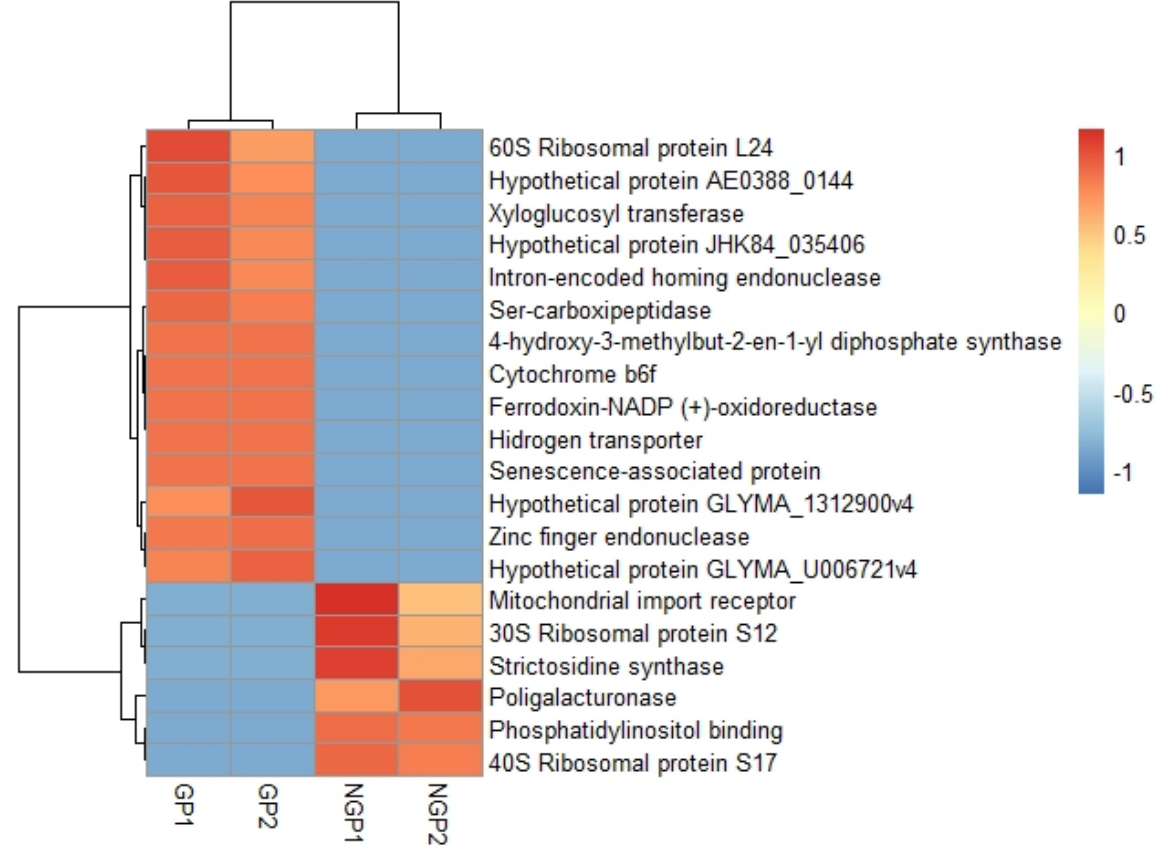
Figure 4. Comparison of transcripts with higher differential expression values between two populations of Galphimia spp. GP1, GP2 (leaves of galphimine producer plants). NGP1, NPG2 (leaves of non-galphimine producer plants). High values are represented in red color, the lowest values are represented in blue.